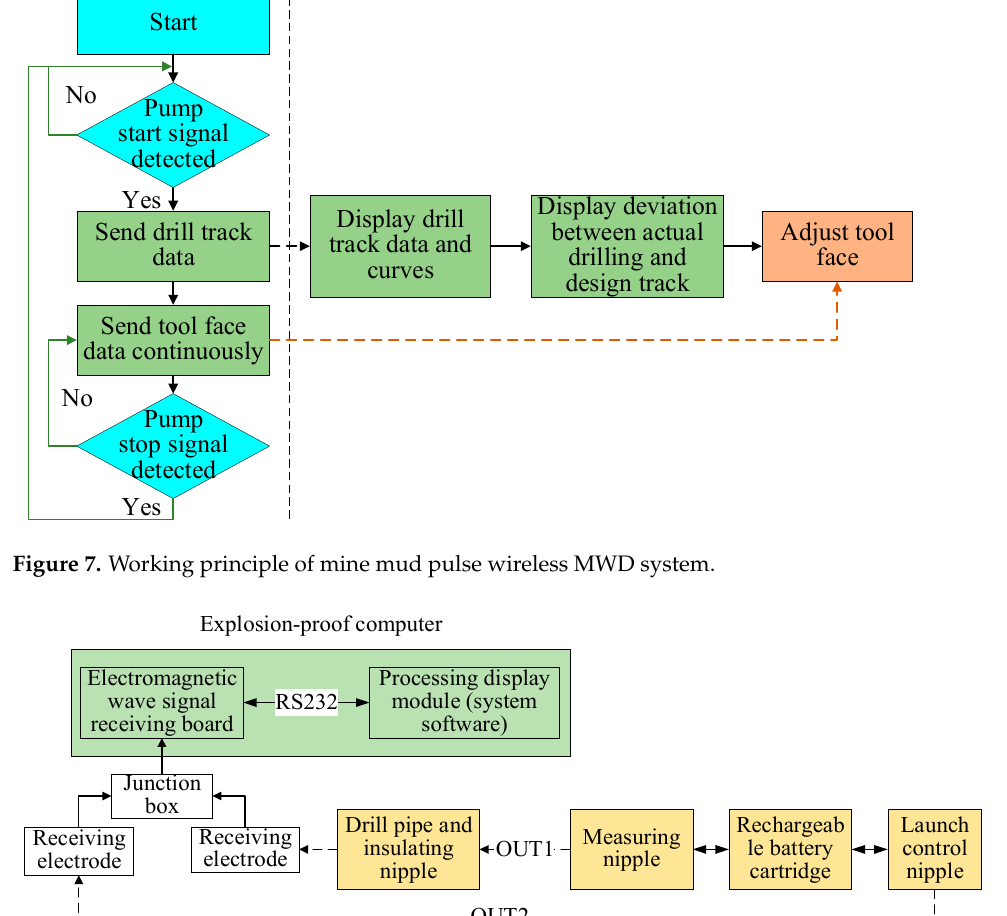
Figure 8. Overall structure design diagram of mine electromagnetic wave wireless measurement while drilling system.